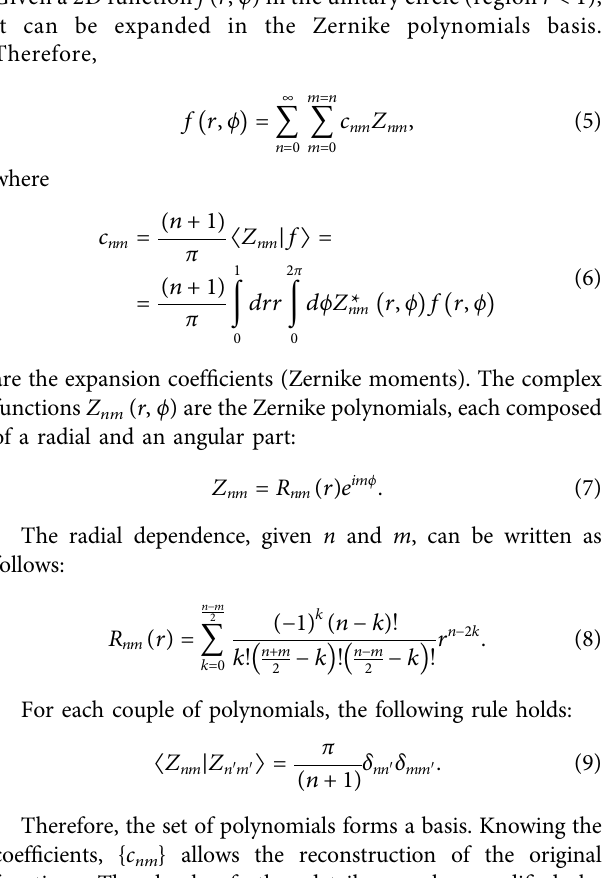
(cid:1) A to any atoms